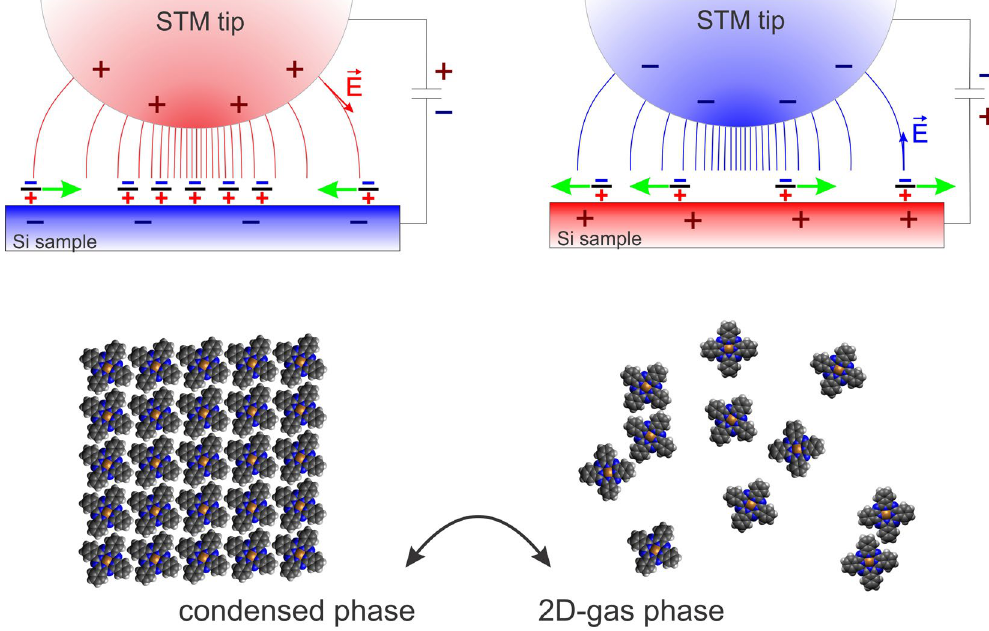
Figure 3. Graphic illustration of the field-controlled switching mechanism. Static dipoles carried by the CuPc molecules are represented schematically by the + / − signs on the surface. Green arrows indicate forces acting upon the dipoles in the electric